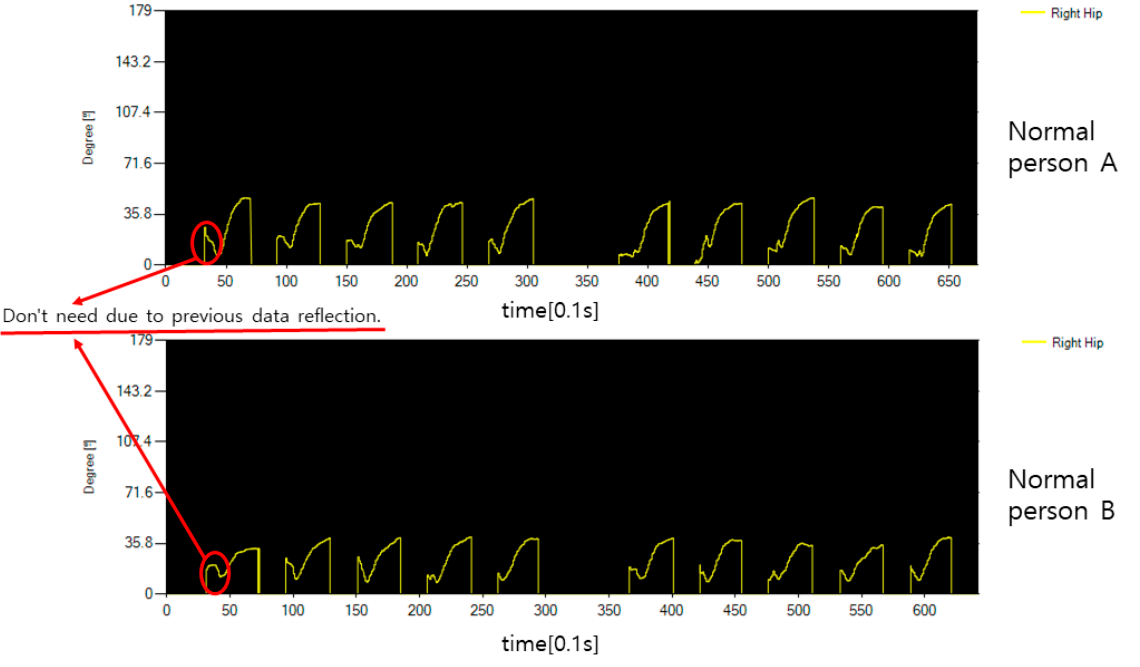
Figure 12. The hip bone angle data of a normal person’s sitting motion.